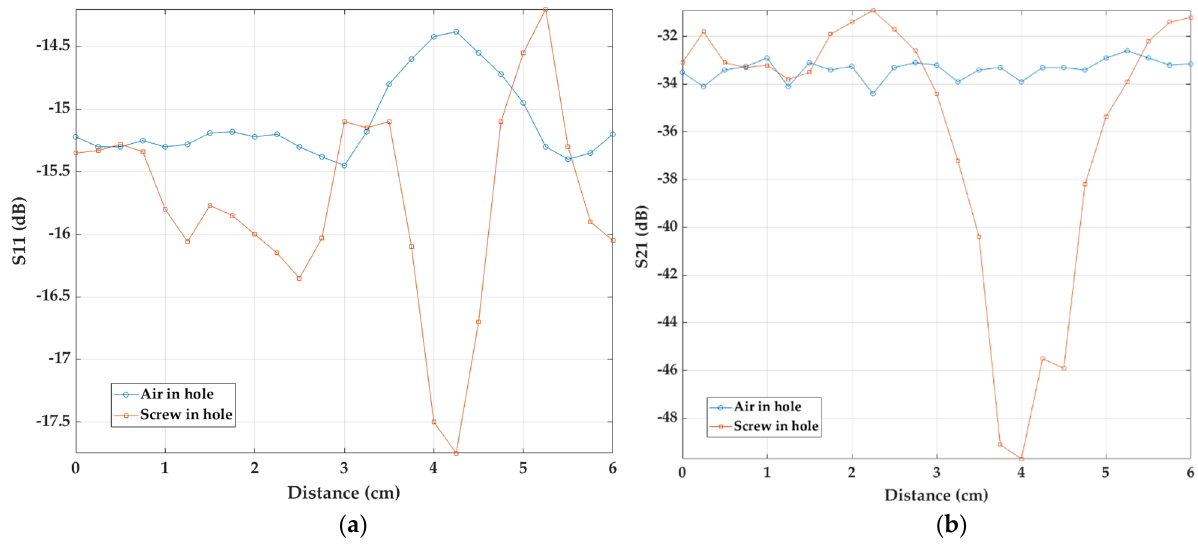
Figure 11. The hole was 10 mm from the measurement surface and at 4 cm: ( a ) S 11 for air-filled hole vs. bolt; ( b ) S 21 for air-filled hole vs. bolt.